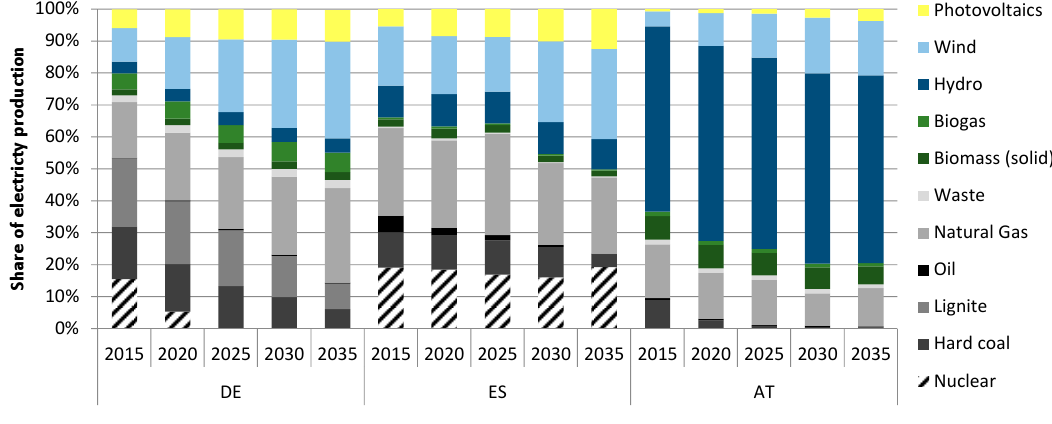
Figure 2. Projected structural change of electricity mixes in Austria, Spain and Germany.